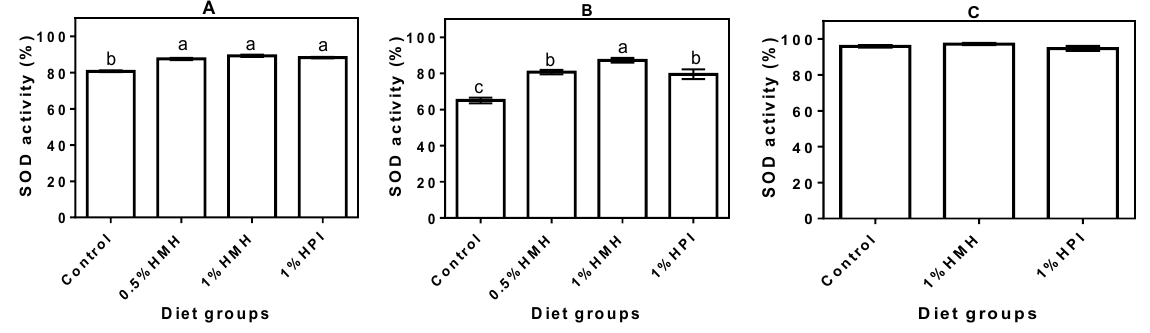
Figure 2. Superoxide dismutase (SOD) activity in plasma of ( A ) young growing spontaneously hypertensive rats (SHRs) (Trial I), ( B ) adult SHRs with established hypertension (Trial II) and ( C ) normotensive rats (Trial III) with a casein-only diet or casein diet that contained hemp seed meal protein hydrolysate (HMH) or hemp seed protein isolate (HPI). Bars with different letters have mean values that are significantly different ( p < 0.05). Values are means ( n = 4 rats) ± SD.